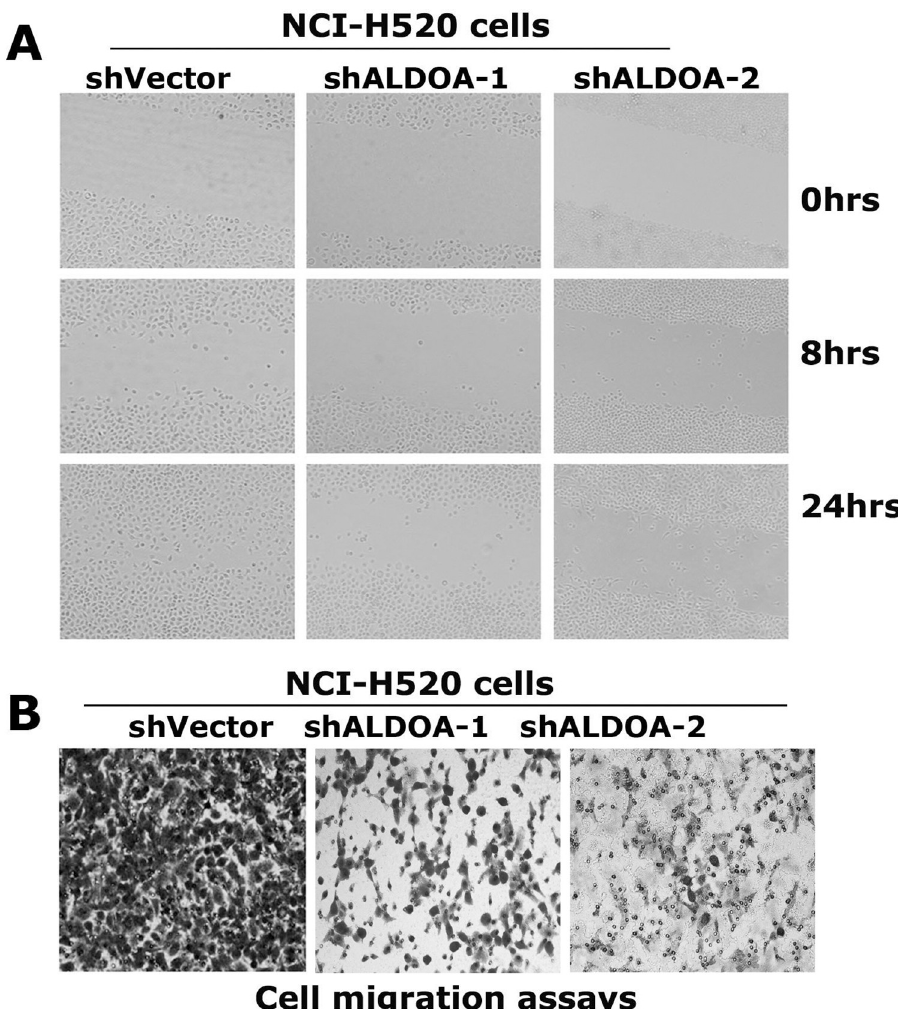
Figure 6. ALDOA is required for migration of the lung cancer cell NCI-H520. (A) Wound-healing assays of the resulting NCI-H520 cells in cultured plates. Cell were grown in petri dishes to 90% confluency and cut with a sterile 200- μ l pipette tip. The resulting cells were continually cultured in serum-free medium and were photographed at 0, 8 and 24 hs post-scratching. The shVector panels in Figure 6A of [1] are reused as the NCI-H520-shRNA-NC panels in Figure 7A of [3]. (B) Cell migration assays using the transwell assays kits. 5 × 10 5 cells per well were plated in the upper chambers of transwell plates with an 8- μ m pore size membrane and media containing 10% FBS was placed in the lower chamber. After 24 hours of culture the cells on the upper surface of the filter were removed. The migrated cells were fixed in 70% methanol and stained with 0.1% crystal violet. The assays were performed in triplicates and at least 6 unbiased fields were counted per